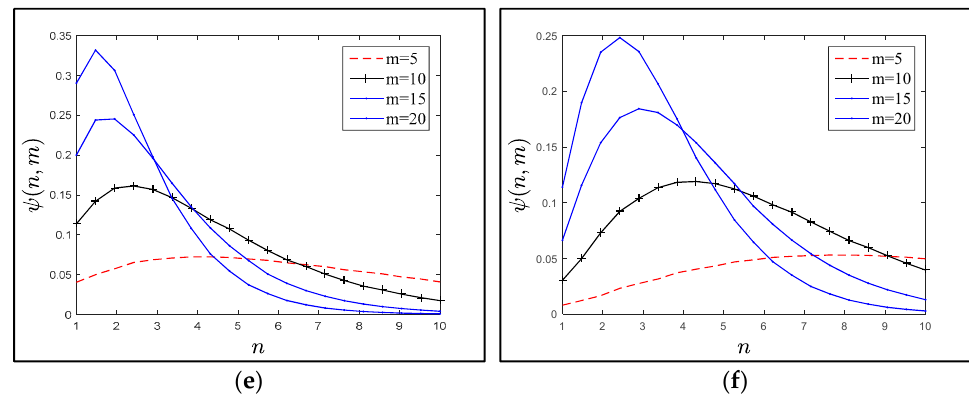
Figure 7. With different residence/request time distributions as in ( a – e ). ( a ) Exponentially distributed residence time, mean µ − 1 , when λ = 10 µ . ( b ) Hypo-exponential distributed residence time, when λ = 2 µ 1 = 20 µ 2 . ( c ) Hypo-exponential distributed residence time, when λ = 10 µ 1 = 2 µ 2 . ( d ) Gamma-distributed residence time is when κ = 1, and λ = 10 µ . ( e ) Gamma-distributed residence time, when κ = 2, and λ = 20 µ . ( f ) Gamma-distributed residence time, when κ = 3, and λ = 30 µ . Figure 8a–c show the effect of m values on the trend of the cost function C( m ) for fixed α , β , and λ . The trend of the plots is the same for various residence time distribution, all plots obviously show that there is a critical value ( m ), which is minimizing the cost function,